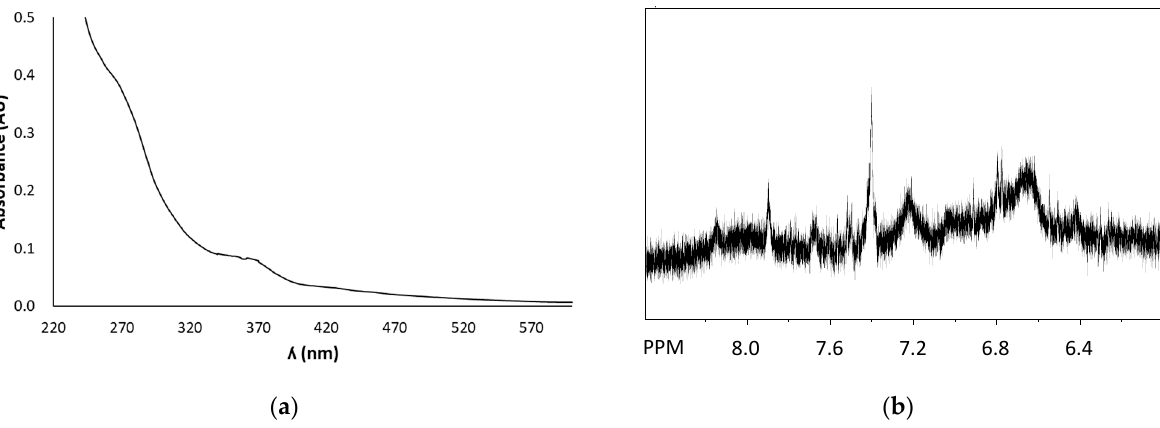
Figure 2. ( a ) UV-Vis spectrum (after dilution 1:200 v / v in methanol) and ( b ) selected region of 1 H NMR spectrum of FSE.